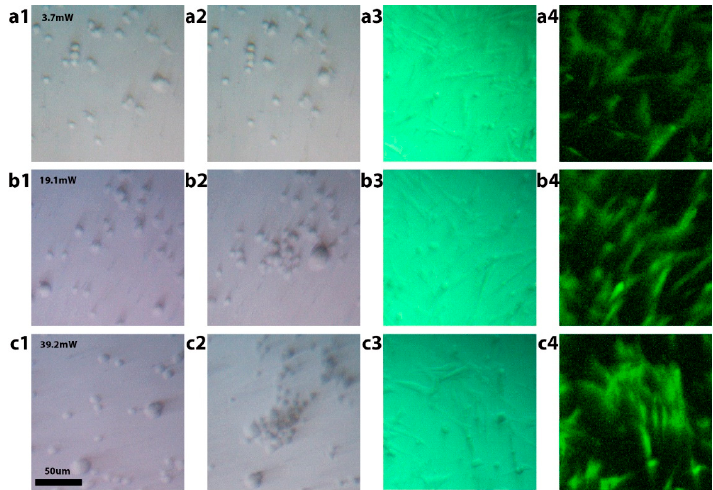
Figure 5. Demonstration of fibroblast cell viability after opto-fluidic manipulation. ( a1,a2 ) Before and after low-power manipulation at 3.7 mW. ( b1,b2 ) Before and after medium-power trapping at 38 mW. ( c1,c2 ) Before and after high-power projection regime at 78 mW. ( a3,b3,c3 ) Bright-field and ( a4,b4,c4 ) fluorescent images of cells after 24 hours of